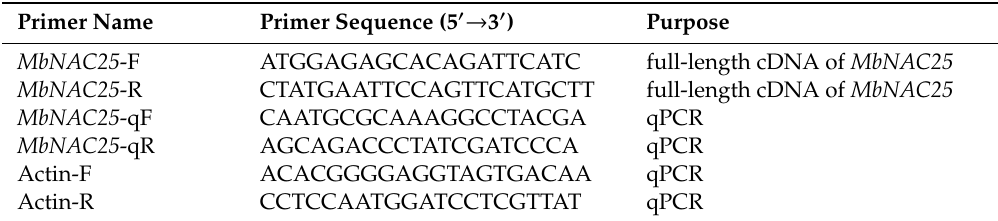
Table 1. List of primers used in this